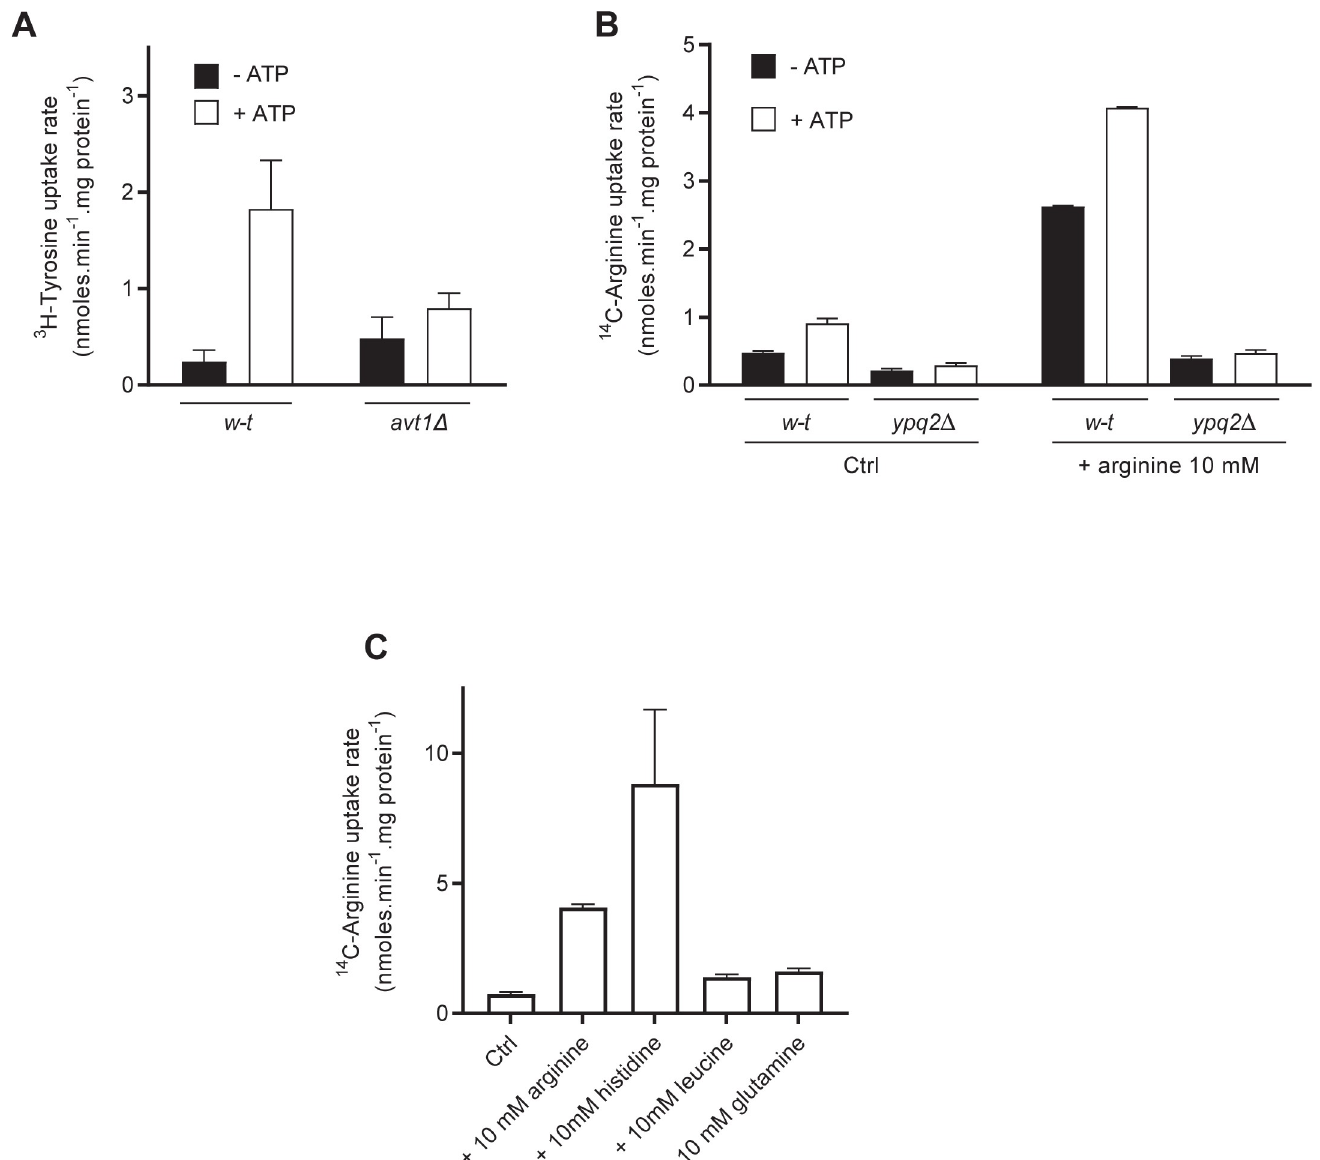
Fig 3. Ypq2 catalyzes an Arg/Arg exchange reaction. (A) Accumulation of 3 H-tyrosine (50 μ M) after a 4-minute incubation was measured in reconstituted vesicles prepared from vacuoles of the w-t and avt1 Δ mutant strains. Vesicles were incubated for 8 minutes in the absence and presence of ATP (4 mM) before addition of 3 H-tyrosine (n = 2). (B) The uptake of 14 C-Arg added at 50 μ M was measured, after a 4-minute incubation, in reconstituted vesicles prepared from vacuoles of the w- t and ypq2 Δ mutant strains. Vesicles generated in a buffer without Arg (Ctrl) or containing 10 mM non-radiolabeled Arg were incubated for 8 minutes in the absence or presence of ATP (4 mM) before addition of 14 C-Arg (n = 2). (C) The uptake of 14 C-Arg added at 50 μ M was measured, after a 4-minute incubation, in reconstituted vesicles prepared from vacuoles of the w-t strain. The vesicles were filled with a buffer without any amino acid (Ctrl) or with 10 mM non-radiolabeled Arg, His, leucine, or glutamine. The vesicles were then incubated for 8 minutes in the presence of ATP (4 mM) before addition of 14 C-Arg (n = 2). For all experiments, error bars represent the